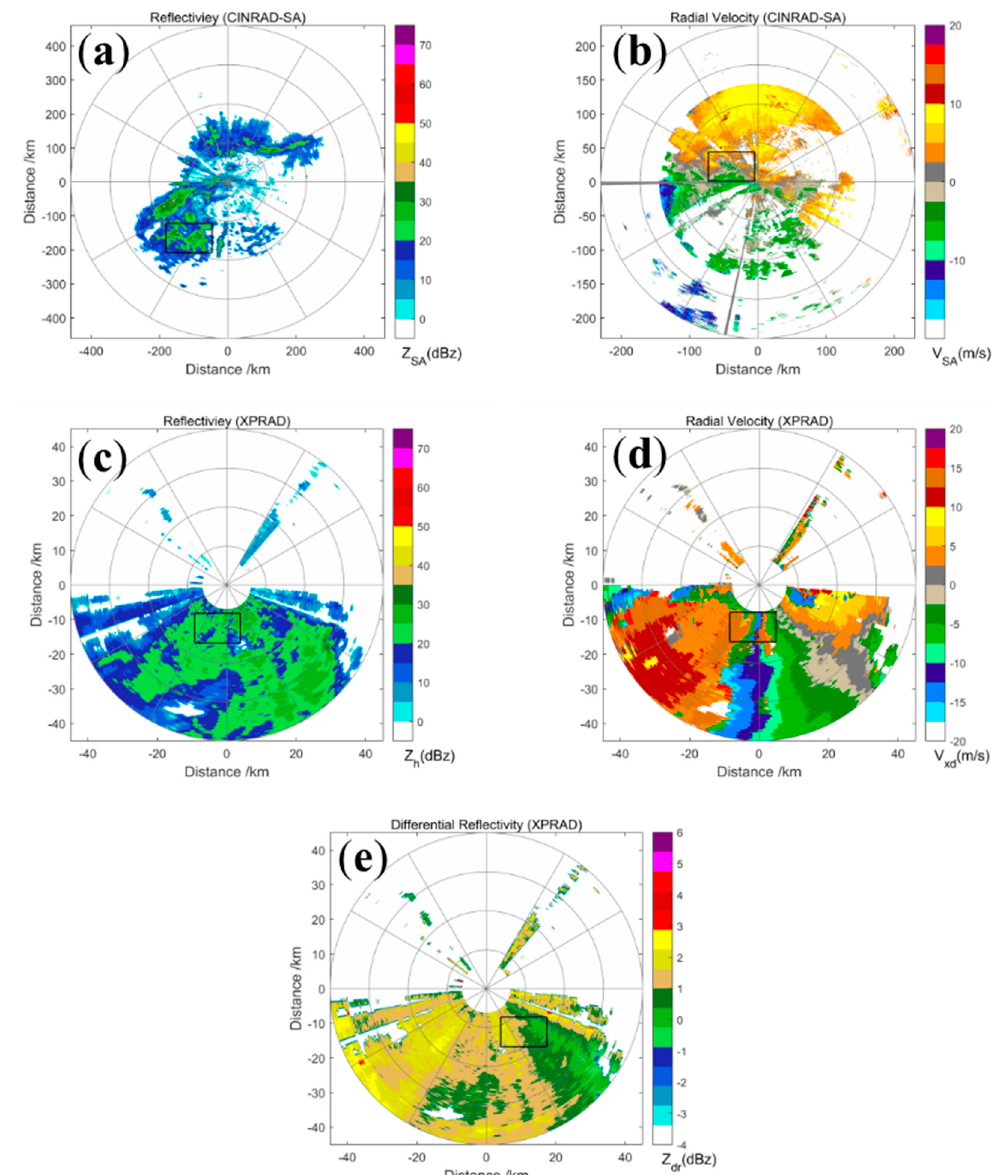
Figure 4. Example test radar echo images with selected patches for comparison shown in Plan Position Indicator (PPI). ( a ) and ( b ) are the first elevation cut of the reflectivity and radial velocity data of the S-band China New-Generation Weather Radar (CINRAD-SA) at Beijing, China on 19 May 2018 at 09:36 (BJT), which has 360 radials with 460 range bins per radial direction for reflectivity, and 920 range bins per radial direction for radial velocity; ( c ), ( d ), and ( e ) are the first elevation cut of reflectivity, radial velocity, and differential reflectivity data of the X-band dual-polarization Radar (XPRAD) radar at Xinfeng, Guangdong on 28 May 2016 at 07:39 (BJT), which has 360 radials with 600 range bins per radial direction.